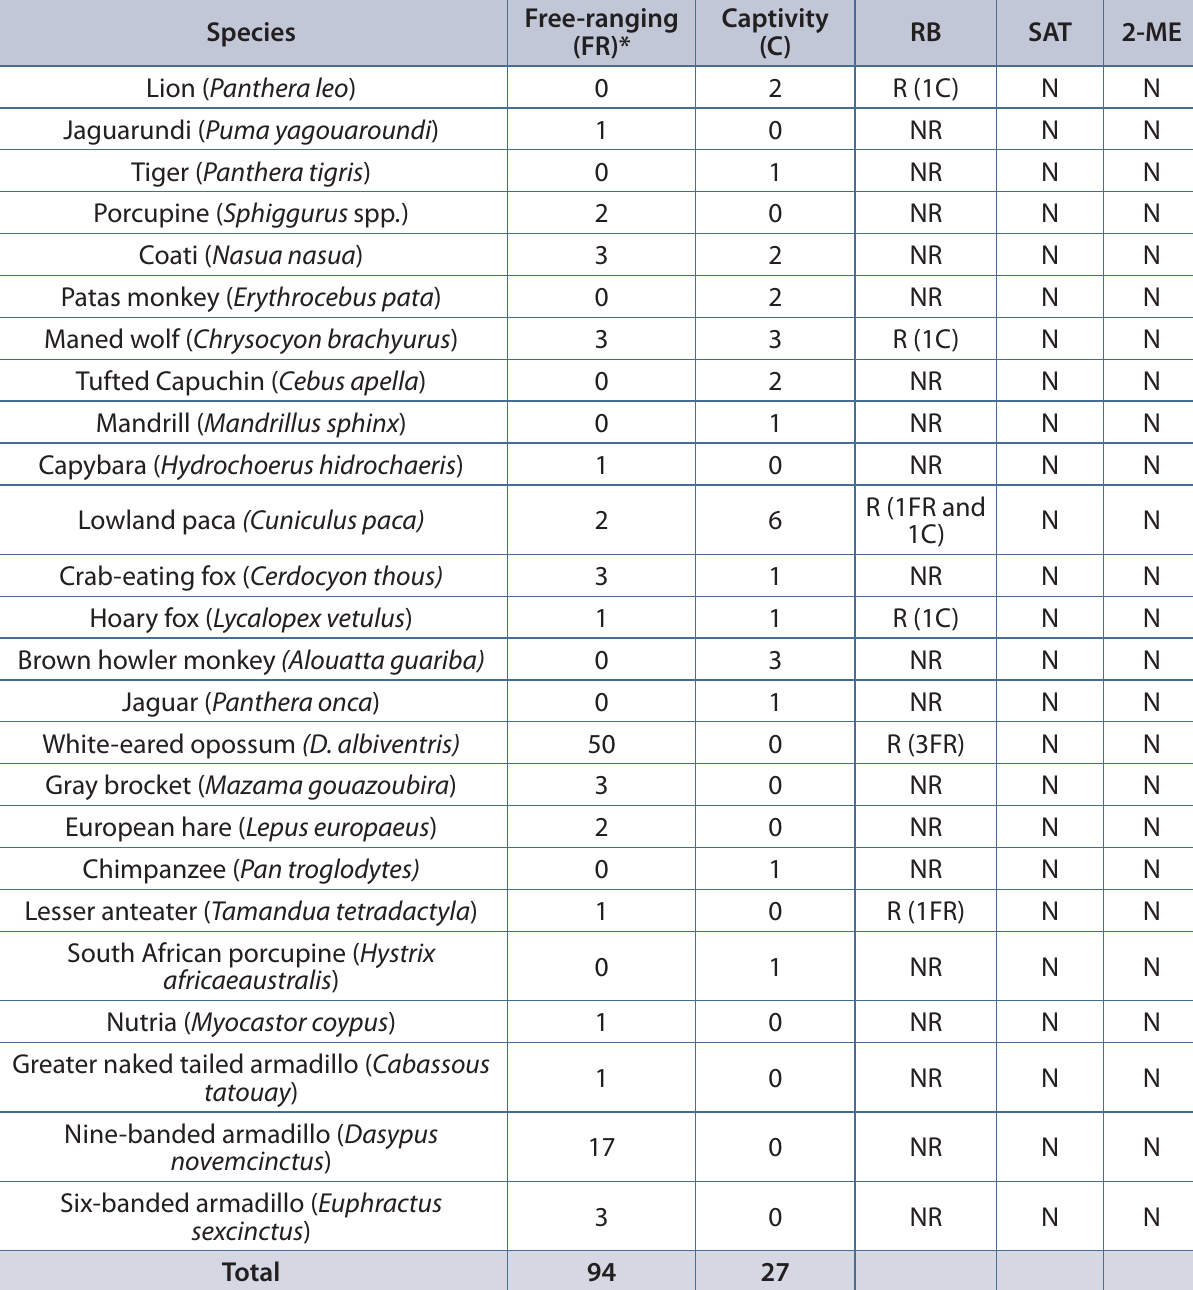
Table 1. Serological results for Brucella spp. infection in free-ranging and captive wild animals from São Paulo state,